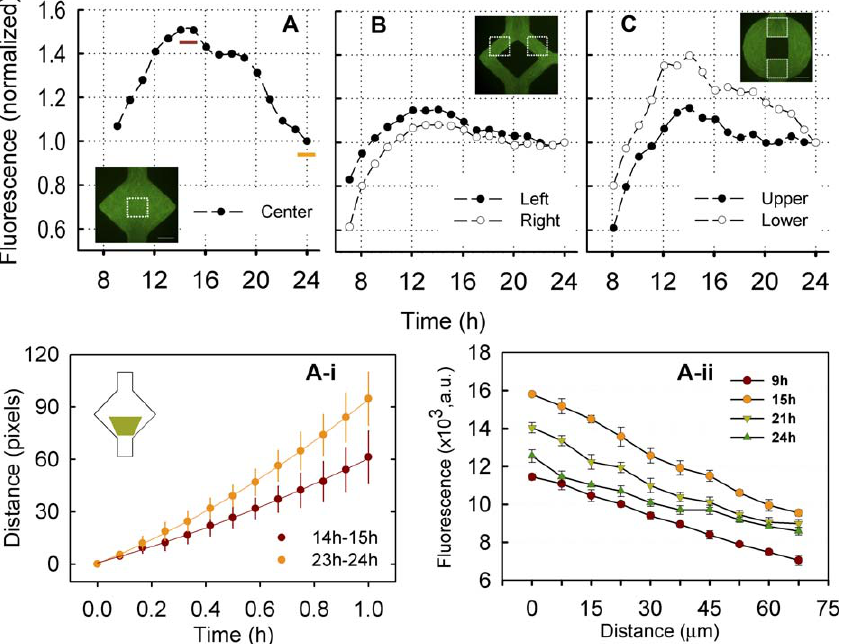
Figure 5. Glucose-Dependent lux Operon-GFP Response in Microchambers with Different Shapes: Rhombus (A), RIR (B), and Square in a Circle (C) The average fluorescence intensities in the selected regions were normalized to their value at the end of the experiment, which was taken as 1. (A-i) the flow of cells from the RIR chamber toward an exit during two time intervals corresponding to the red and orange bars in (A). An average of distances traveled by 10 tracked cells from their initial positions is shown as a function of time. The tracking was done in the region indicated by the green trapezium in the inset. The error bars are standard deviation. Each plot was fitted to a quadratic curve. (A-ii) the fluorescence intensity within the rhombus chamber was measured at indicated times along a line from the center (0 l m) to an exit (65 l m). Note the correspondence of the variation in the absolute intensity at distance 0 l m with the temporal variation shown in (A). Each data point represents the mean fluorescence value 6 standard deviation from square regions containing approximately 30 cells each.